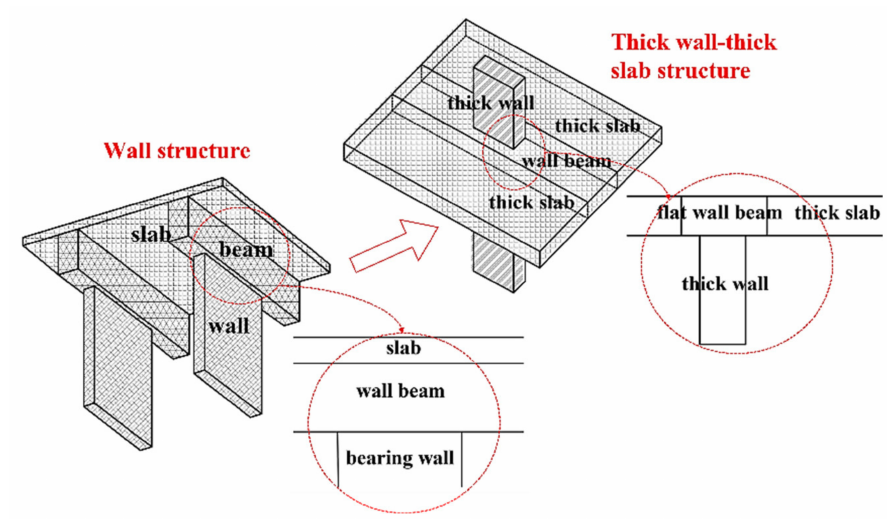
Figure 3. Development of thick wall-thick slab